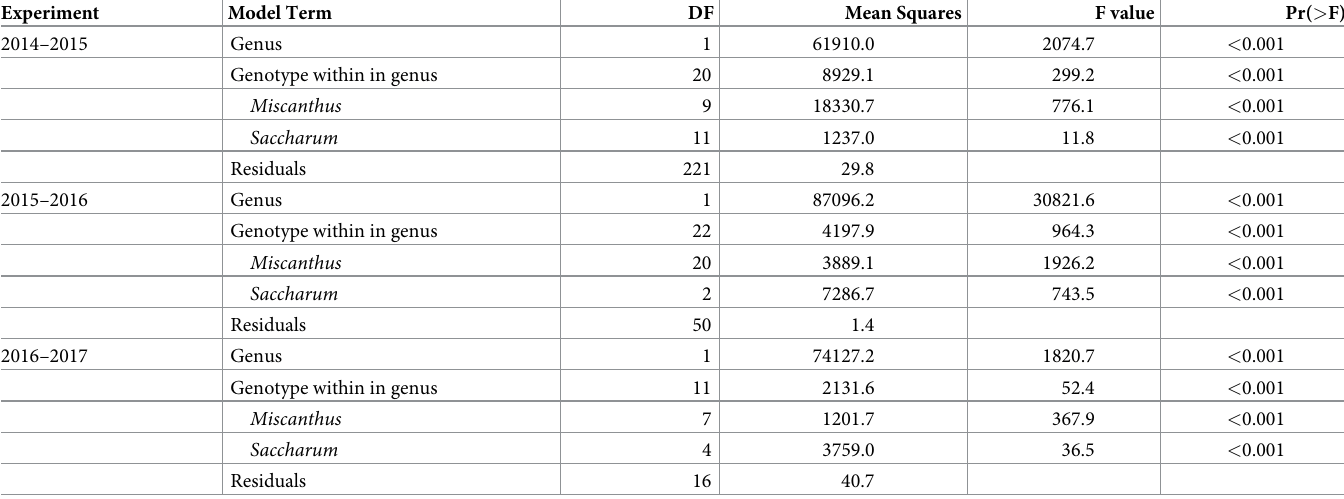
Table 4. Effect of genus ( Miscanthus and Saccharum ) and genotype within each genus on days to first flower for a series of experiments conducted in a greenhouse at Urbana, IL over three years. Experiment